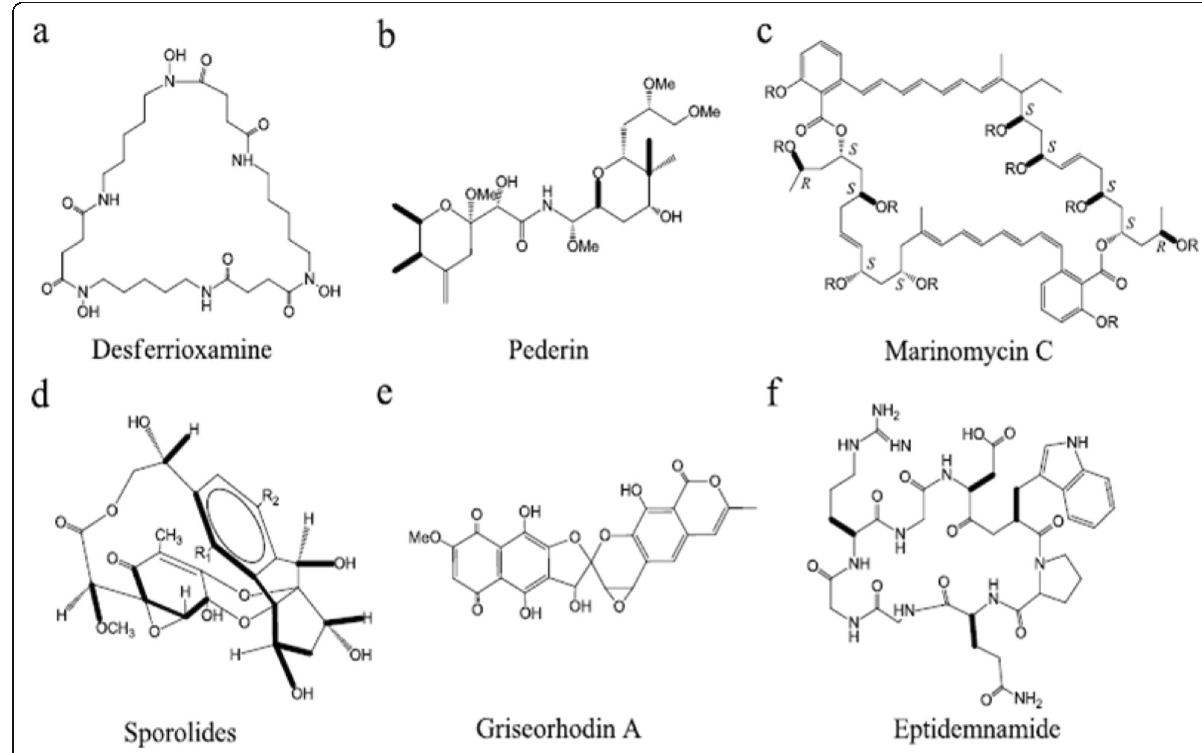
Fig. 1 Structures of some marine microbial bioactive